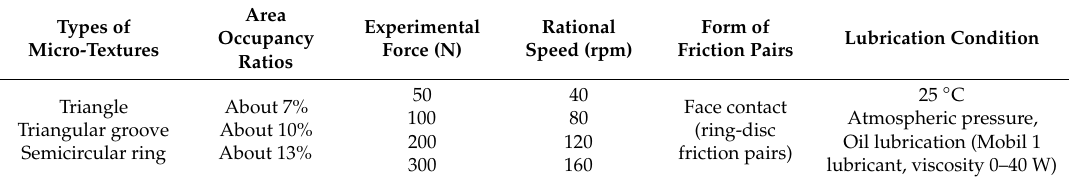
Table 7. Experimental scheme and the values of the relevant condition